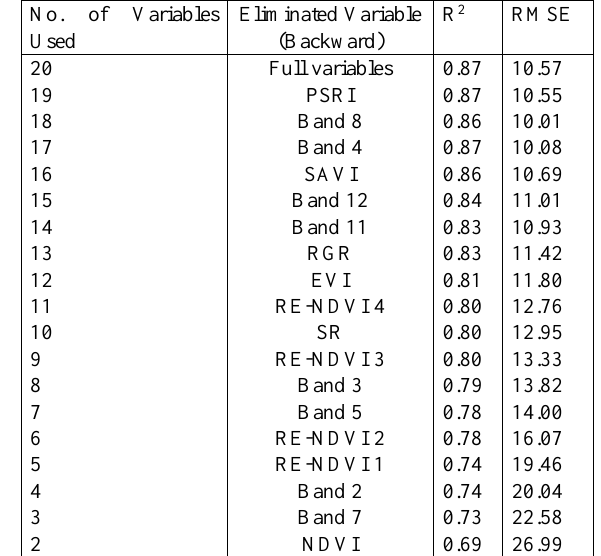
RFR also calculates the relevance of the input variables using IncNodePurity. As shown in Figure 3, the most influential features pose in the red edge spectral region, which confirm the results achieved in pandit et al., (2018). The spectral band 8a in the most important feature, however, band 8 in the same spectral region belongs to the impractical features. It may related to the spectral resolution, while band 8a has five times lower bandwidth. The variable selection method used in this study identified the smallest subset of predictor variables in the